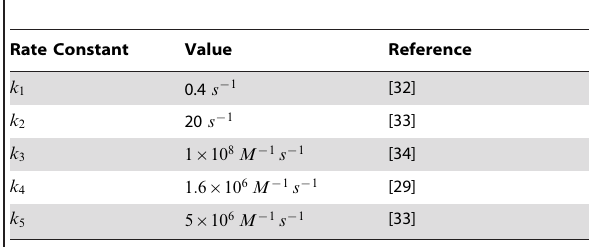
Table 4. Table of kinetic rate constants.